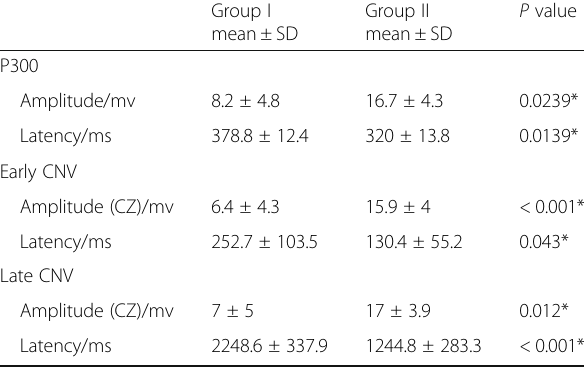
Table 2 Comparison between CNV results in both groups